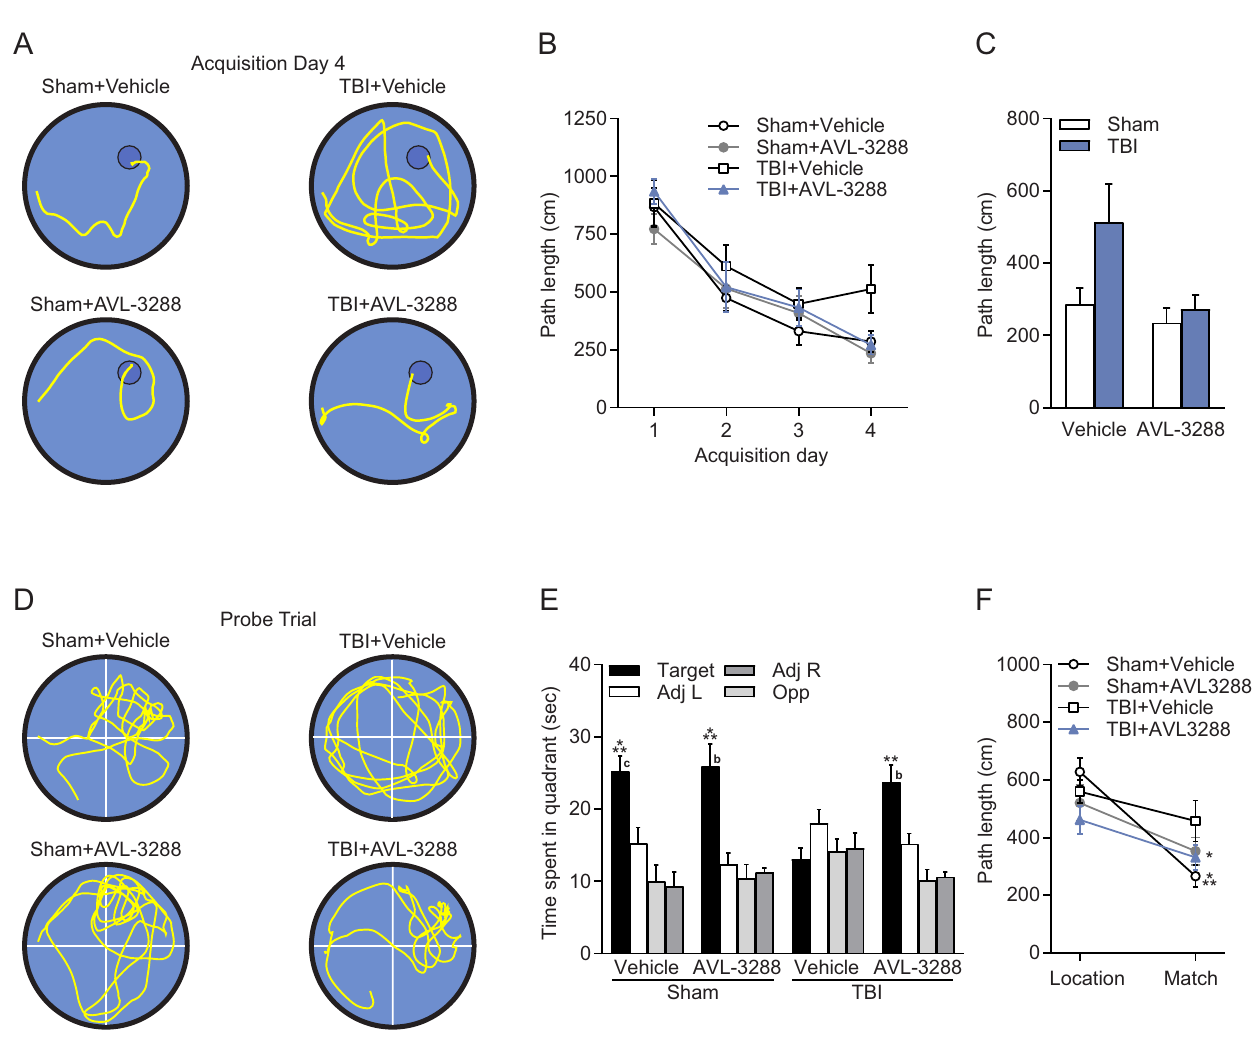
Fig 3. Water maze. AVL-3288 treatment improved spatial memory in TBI animals. A) Representative swim tracks from acquisition day 4. B) Swim path length during water maze acquisition. C) Path length on acquisition day 4. D) Representative swim tracks during the probe trial with the platform removed from the northeast, target quadrant. E) Time spent in each quadrant of the water maze during the probe trial. �� p < 0.01, ��� p < 0.001 vs. Other Quadrants, b p < 0.01, c p < 0.001 vs. TBI+Vehicle Target Quadrant, two-way ANOVA with Tukey’s HSD post-hoc test. F) Path length to reach the platform on the location and match trials, with a 5 s interval between trials to assess working memory. � p < 0.05 for Sham+AVL-3288 and TBI+AVL-3288 Location vs. Match trials, ��� p < 0.001 for Sham+Vehicle Location vs. Match trials, repeated measures two-way ANOVA with Tukey’s HSD post-hoc test. Mean ± SEM, n = 10 Sham+Vehicle, n = 8 Sham +AVL-3288, n = 11 TBI+Vehicle, n = 11